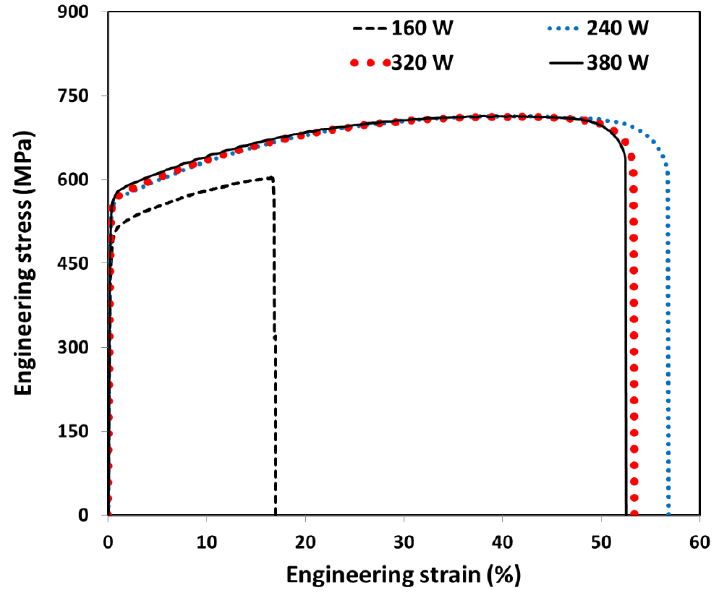
Figure 12. Average tensile stress – strain curves for as-built 316LSS produced at laser powers of 160 W, 240 W, 320 W, and 380 W. Table 6. Average as-built static tensile properties of 316LSS.